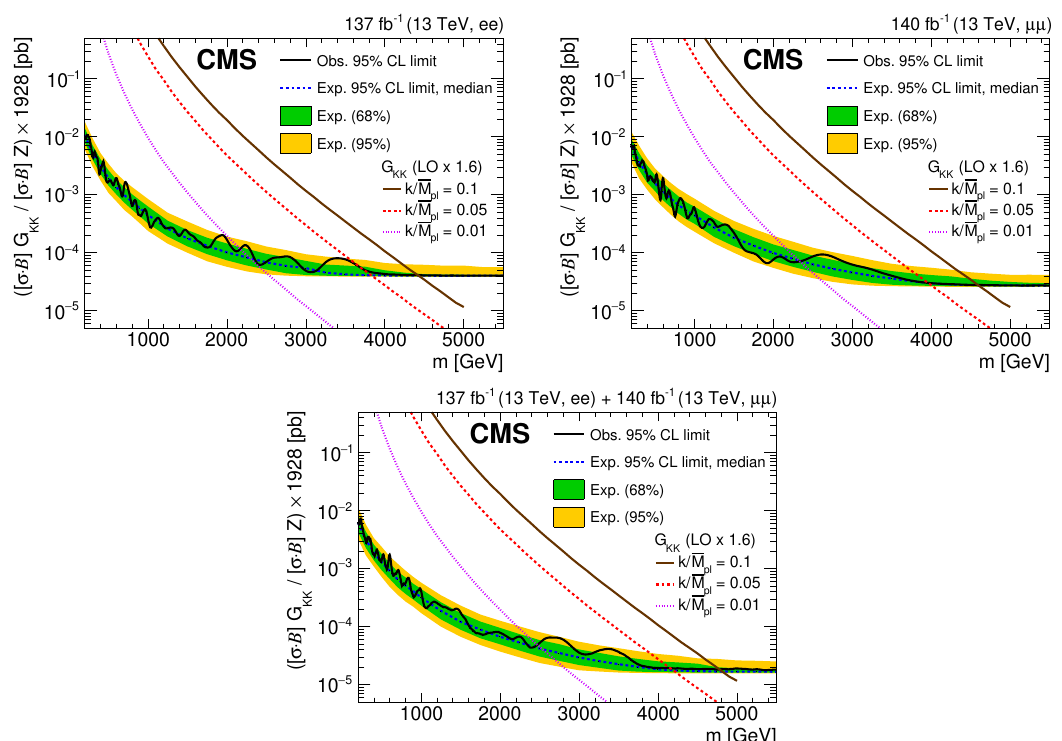
Figure 8 . The upper limits at 95% CL on the product of the production cross section and the branching fraction for a spin-2 resonance, relative to the product of the production cross section and the branching fraction of a Z boson, multiplied by the theoretical value of σ (pp → Z + X → ‘‘ + X ) of 1928 pb, for (upper left) the dielectron channel, (upper right) the dimuon channel, and (lower) their combination. The shaded bands correspond to the 68 and 95% quantiles for the expected limits. Theoretical predictions for the spin-2 resonances for widths equal to 0.01, 0.36, and 1.42% corresponding to coupling parameters k/M of 0.01, 0.05, and 0.10, respectively, are shown for Pl comparison.